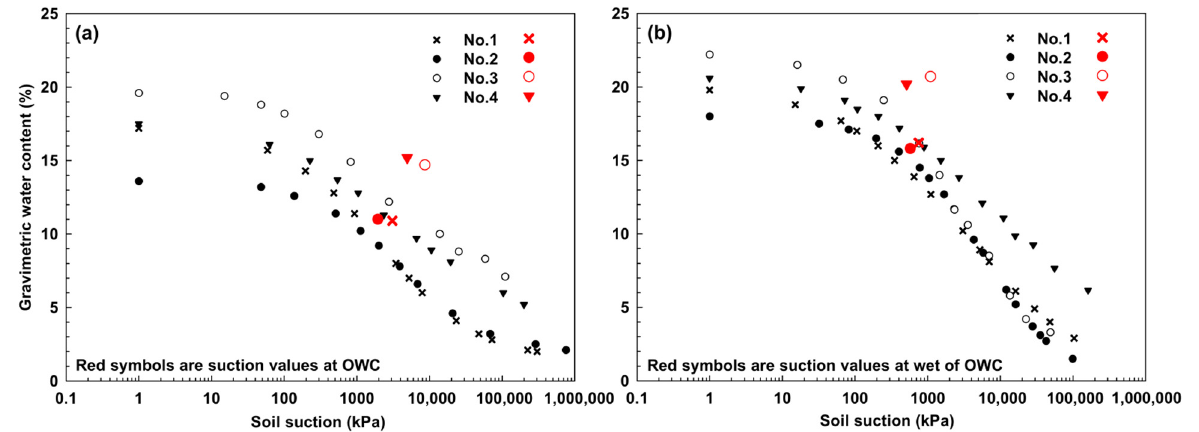
Figure 7. Initial suction of samples compacted at ( a ) OWC and ( b ) wet side of OWC and drying SWCC patterns after saturation. SWCC patterns after